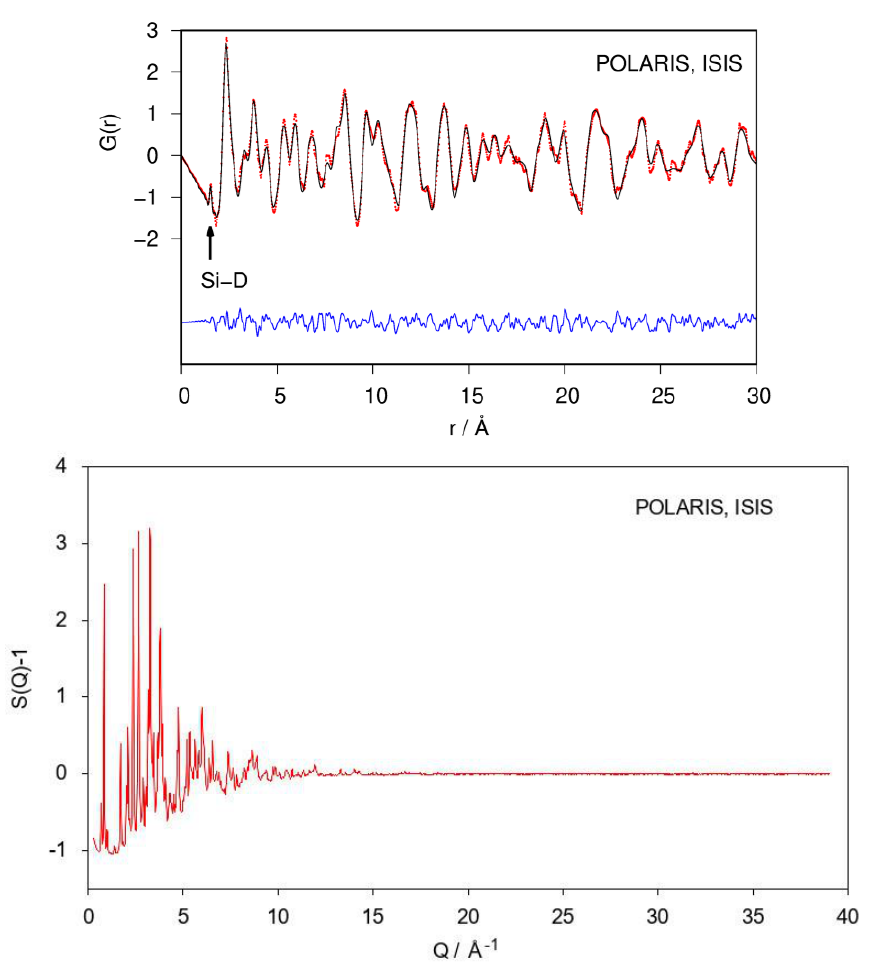
Figure 3. Refinement of the crystal structure of CaSiD 1.1 (space group Pnma ) using neutron pair distribution function (PDF)-data ( top ) and corresponding S(Q) ( bottom ). The Si–D correlation is marked. R wp = 0.165. Red points, observed intensity; black line, calculated intensity; blue line, di ff erence plot. Crystallographic data of CaSiD 1.1 , according to a Rietveld refinement with a bond length restraint ( a = 14.579(4) Å, b = 3.8119(4) Å, c = 11.209(2) Å) and PDF small-box modelling ( a = 14.594 Å, b = 3.8200 Å, c = 11.230 Å). Lattice parameters of the corresponding hydride CaSiH ≈ 1.1 are a = 14.6356(10) Å, b = 3.81207(15) Å, c = 11.2115(7) Å, based on laboratory X-ray di ff